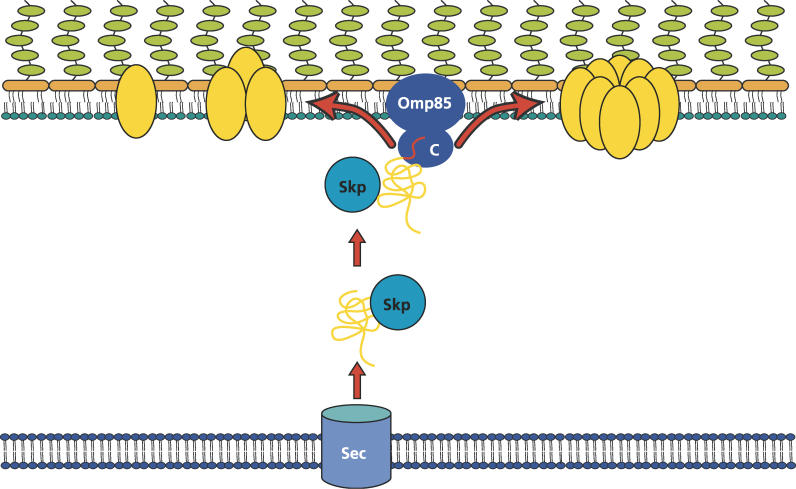
Planar lipid bilayer experiments revealed that the evolutionarily conserved assembly factor Omp85 recognizes the signature motif present at the C termini of bacterial OMPs.